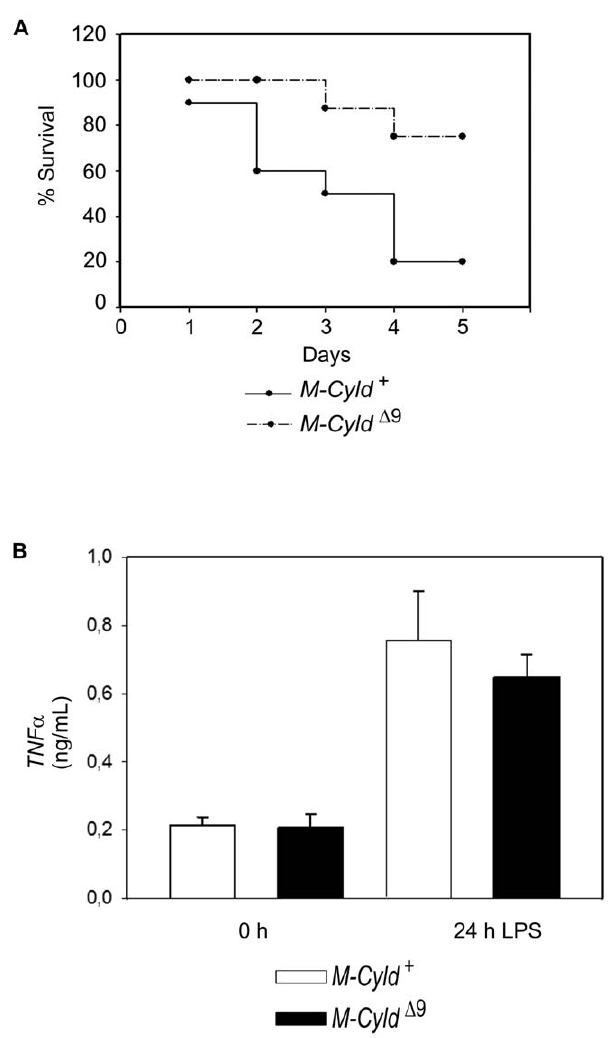
Figure 4. Attenuation of LPS-induced endotoxic shock in M-Cyld D 9 mice. A) Ten control (4 Cyld flx9/ + and 6 Cyld flx9/ + LysMcre ) and eight M-Cyld D 9 mice were subjected to LPS induced endotoxic shock (32 mg LPS/kg) and survival was monitored for the next 5 days. M-Cyld D 9 mice exhibited increased resistance to endotoxemia in comparison to control mice. Data are depicted as mean absolute numbers ( 6 SEM) from n=10 control and 8 M-Cyld D 9 mice at 8 weeks of age. (p value=0,02 as assessed by Student’s unpaired t test). B) Concentrations of TNF a were measured by enzyme-linked immuno- sorbent assay in supernatants from control and M-Cyld D 9 BMDMs before and 24 h after treatment with 100 ng/mL LPS. The results shown are the means ( 6 S.D.) of triplicate measurements. Control BMDMs were isolated from 3 wild type and 4 Cyld flx9/ + LysMCre mice and M-Cyld D 9 BMDMs were isolated from 4